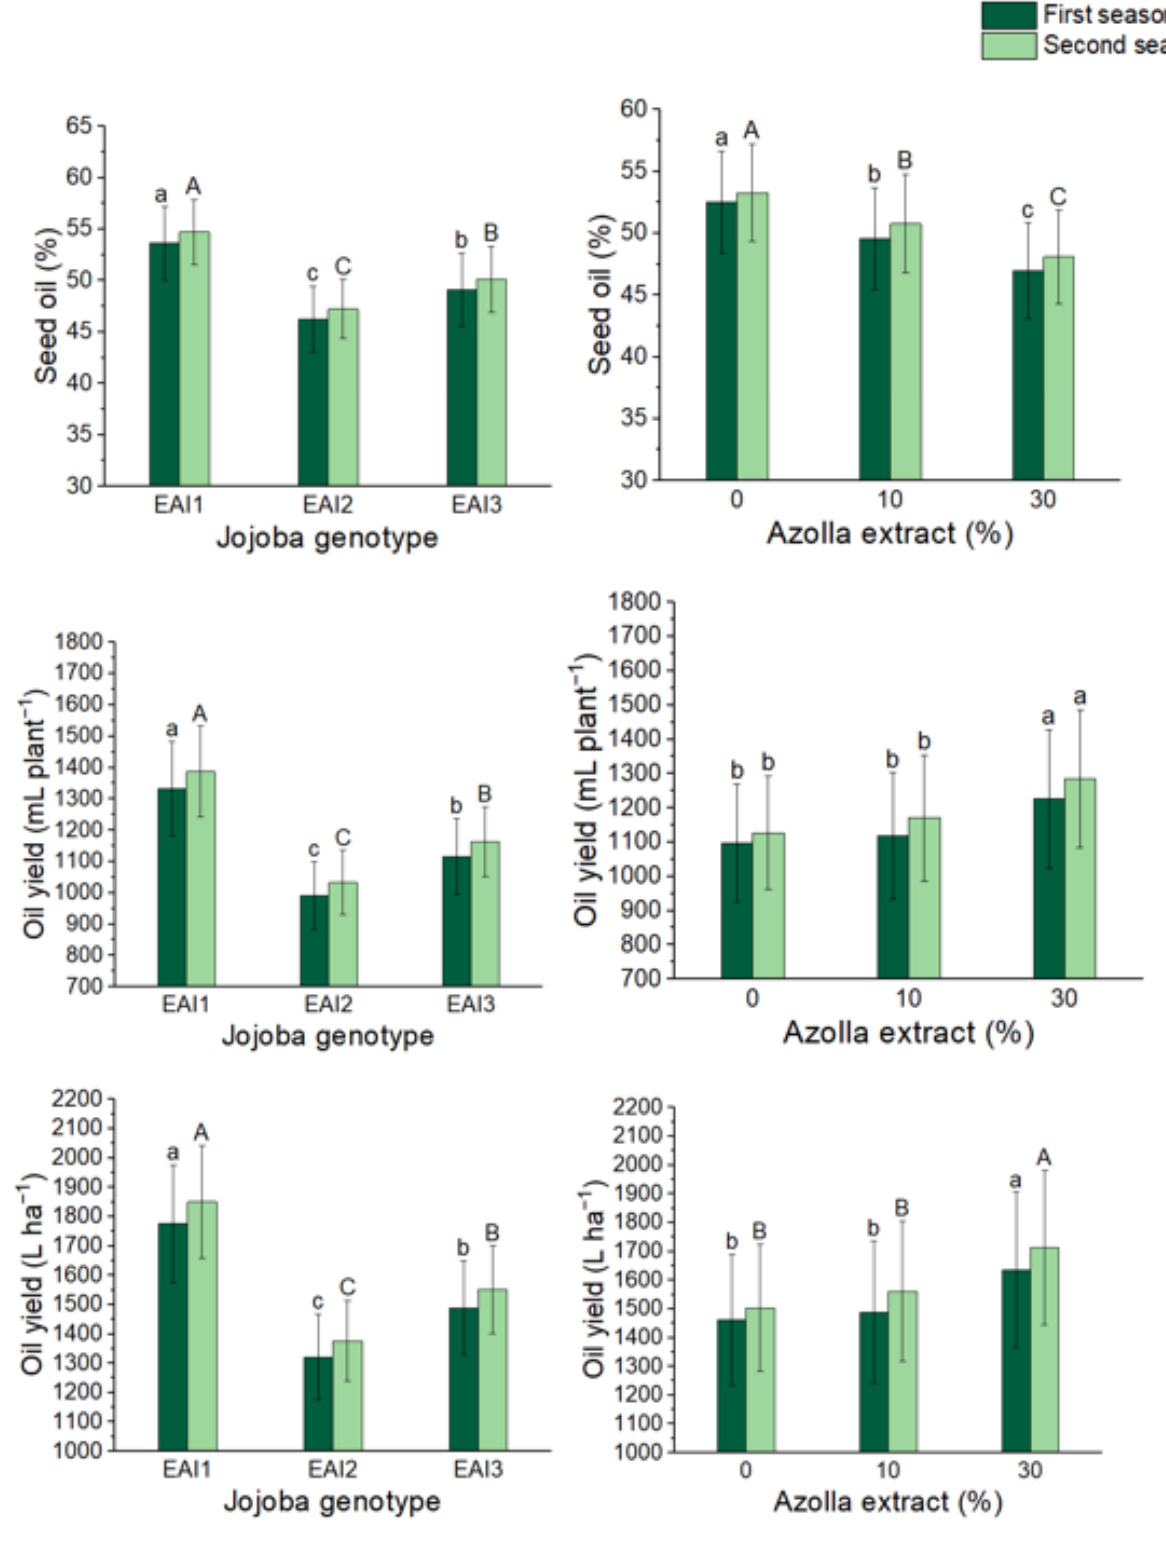
Figure 5. In both seasons, the mean values of oil percent (%), oil content (mL plant − 1 ), and oil yield (L ha − 1 ) of jojoba shrubs were modified by plant genotypes and foliar application of Azolla filiculoides Lam. plant extract respectively. The data are expressed as a mean value ± SE. At the 0.05 level, bars with identical letters are not significant.